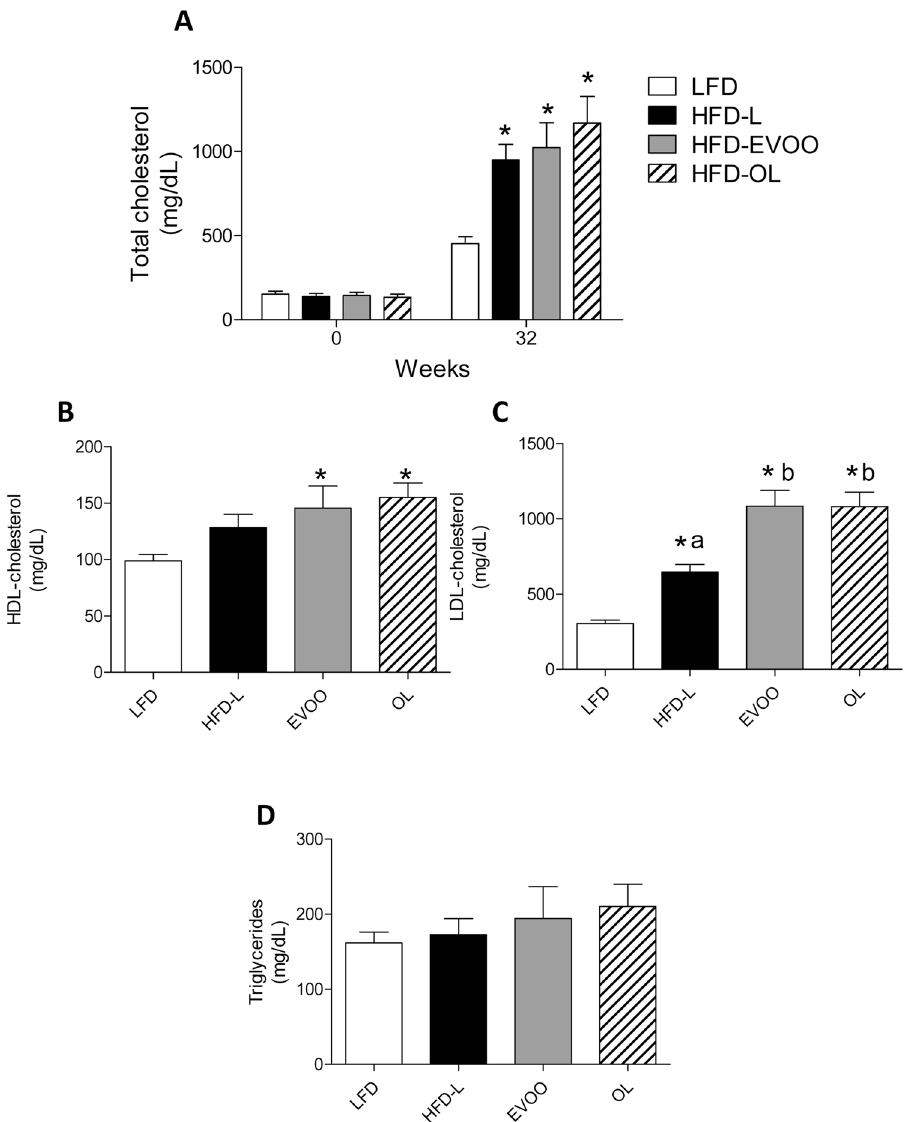
triglycerides values, at the end of nutritional intervention study. N = 12. Values are the means ± SEM. *p < 0.05 LFD vs HFDs groups (HFD-L, HFD-EVOO and HFD-OL); different letters indicate significant differences among HFD groups ( p <